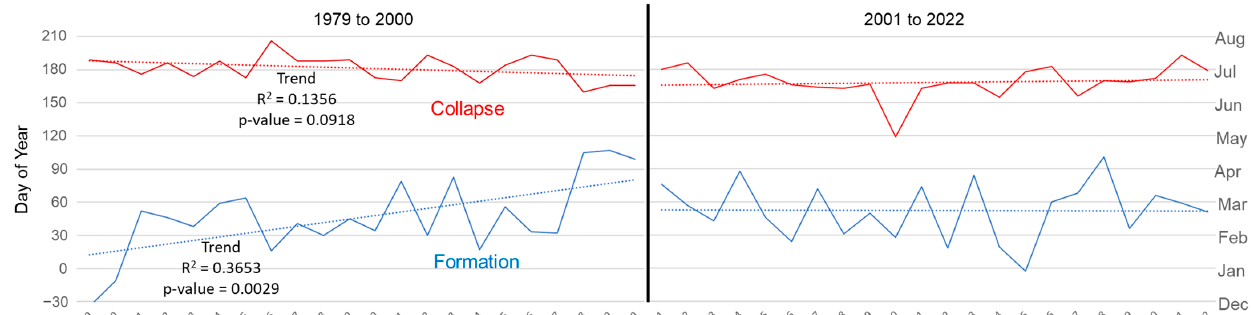
Figure 12. Trends for the formation and collapse of the Lancaster Sound ice arch for 1979 to 2000 (left side of graph) and from 2001 to 2022 (right side of graph). Formation date increases dramatically from 1979 to 2000, with a small decrease in collapse date. From 2001 to 2022, there is essentially no trend in either the date of formation or collapse.